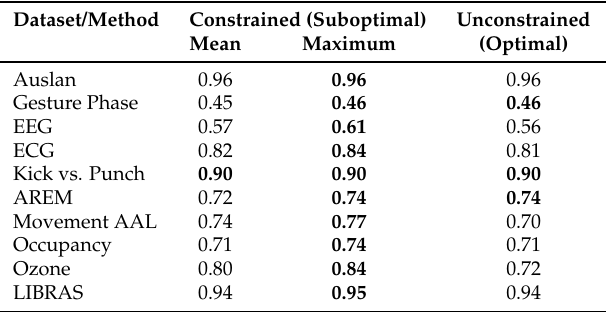
Table 5. Influence of the introduced constraint on the average performance of NN-DTW classifier with augmented data generated by SPAWNER. The best result for each benchmark dataset is written in bold and rounded to two significant figures.